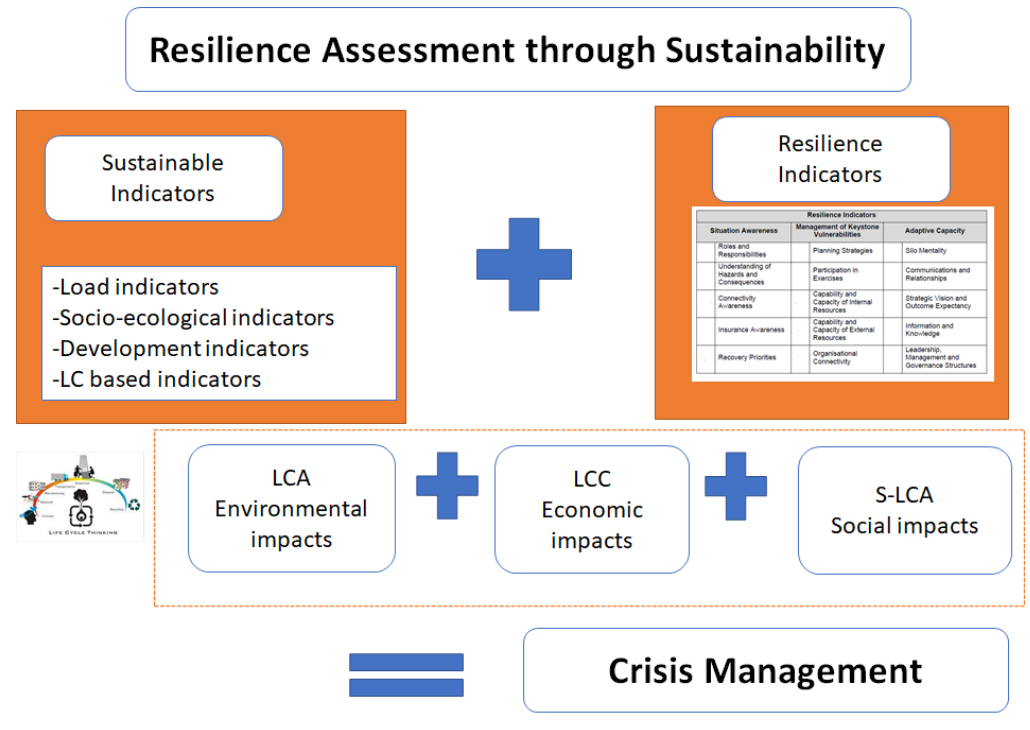
Figure 4: General Framework: LCSA Integration in Resilience